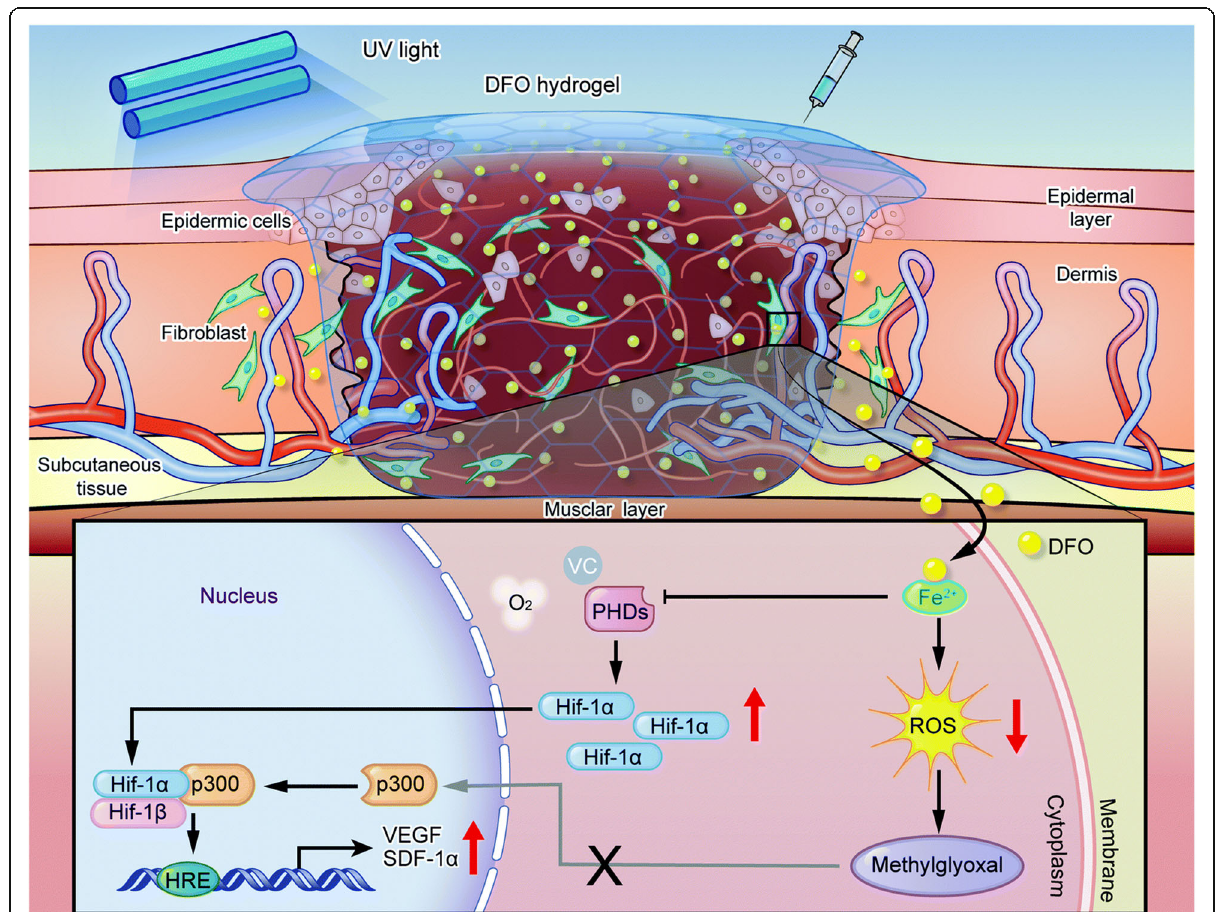
Fig. 11 Schematic diagram of DFO – GelMA hydrogels promoting wound healing by regulating HIF-1a signaling pathways. Reproduced with permission [127]. Copyright (2016), The Royal Society of